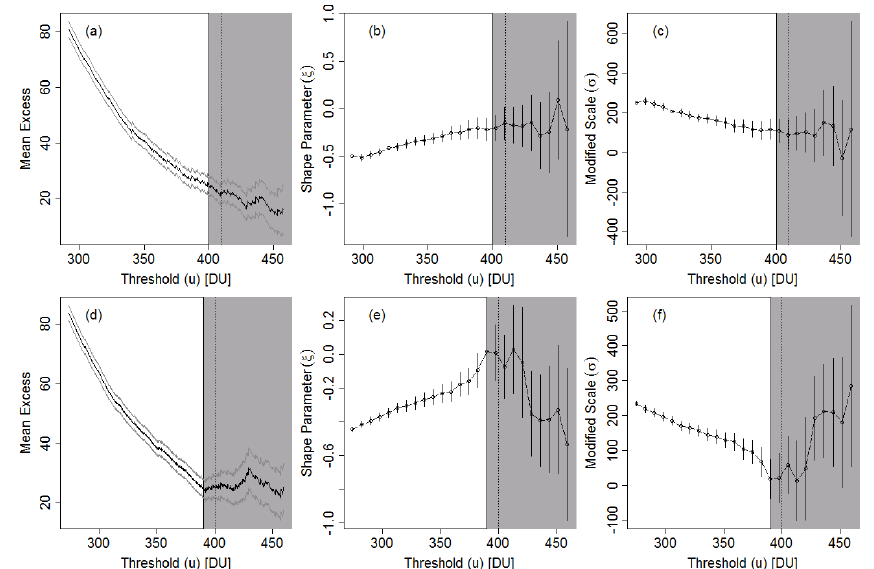
Fig. 4. Threshold selection plots (examples for high total ozone in March 1927–1959): (a) Mean Residual Life Plot (MRL-Plot) and (b–c) stability plots (TC-plots) computed with POT-package (Ribatet, 2007). (d–f) same as (a–c) but for period 1960–2008. Grey area gives stability region and the dashed vertical line gives the selected threshold ( u = 410DU period 1927–1959 and u = 400DU period 1960–2008) in all